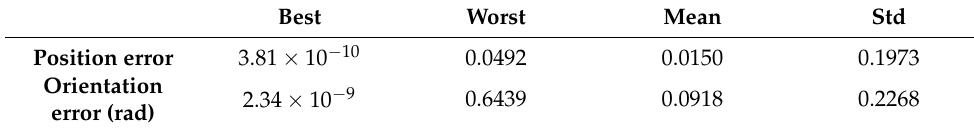
Figure 5. Multi-objective m-PSO for inverse kinematics with position and orientation objectives: ( a ) Pareto front for position error/orientation objectives, ( b ) visualization of robot arm. Table 2. Statistical results of MO-M-PSO target point with end-effector orientation. Best